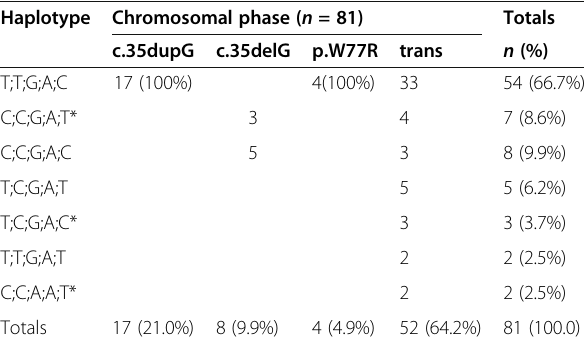
Table 3 GJB2 intragenic haplotypes in hearing impaired and in normal hearing subjects among carriers/noncarriers of mutations c.35dupG, c.35delG, and p.W77R Haplotype Chromosomal phase ( n = 81) c.35dupG c.35delG p.W77R